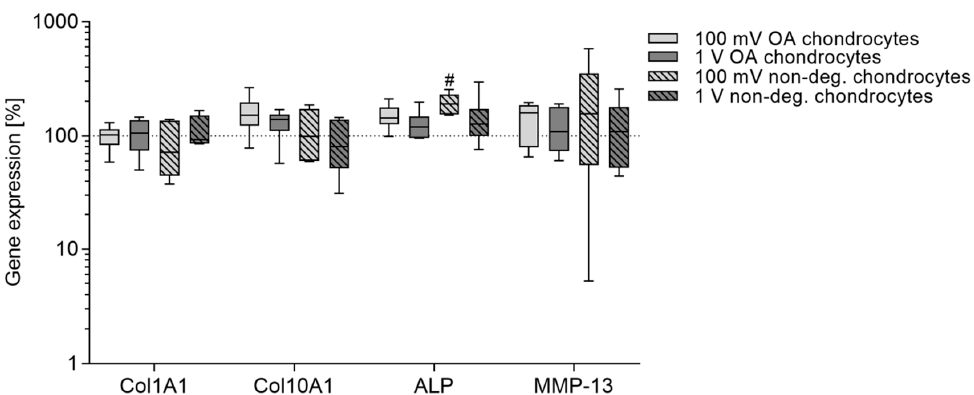
Figure 7. Relative gene expression rates of de-differentiation and hypertrophy markers in chondrocytes after electrical stimulation with 100 mV and 1 V at 1 kHz. Chondrocytes derived from non-degenerative ( n = 4) or osteoarthritic (OA) cartilage ( n = 6) were seeded on collagen scaffolds and stimulated over a period of seven days. Afterwards, the gene expression of chondrogenic de-differentiation and hypertrophy markers was determined via a semi-quantitative polymerase chain reaction (qPCR). Data are presented as boxplots of the percentage of 2 ( −ΔΔ Ct) related to unstimulated cells (100%). Statistical analysis within a stimulation group was performed with Friedman test by using the ΔΔ Ct-values ( # p < 0.05).